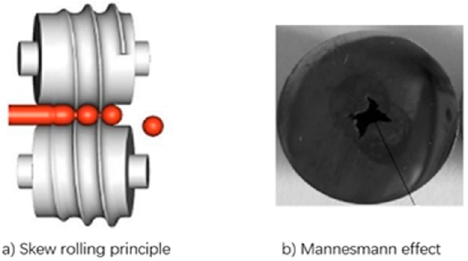
Figure 1. Scheme diagram of skew rolling steel balls and Mannesmann e ff ect. ( a ) Skew rolling principle; ( b ) Mannesmann e ff ect.